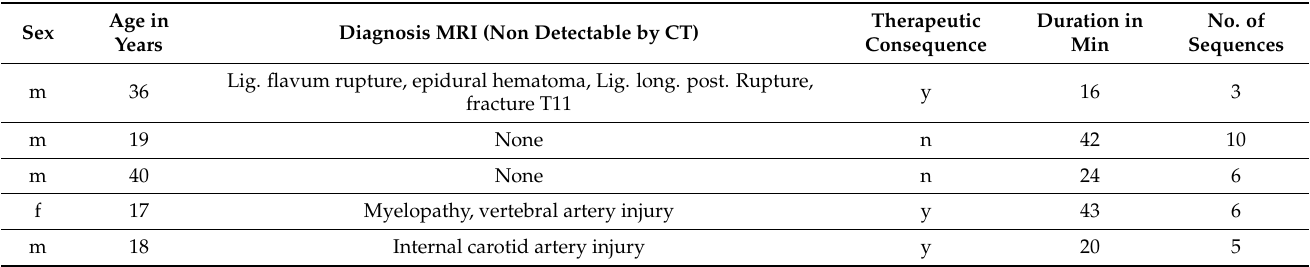
Table 4. Evaluation of MRI-specific